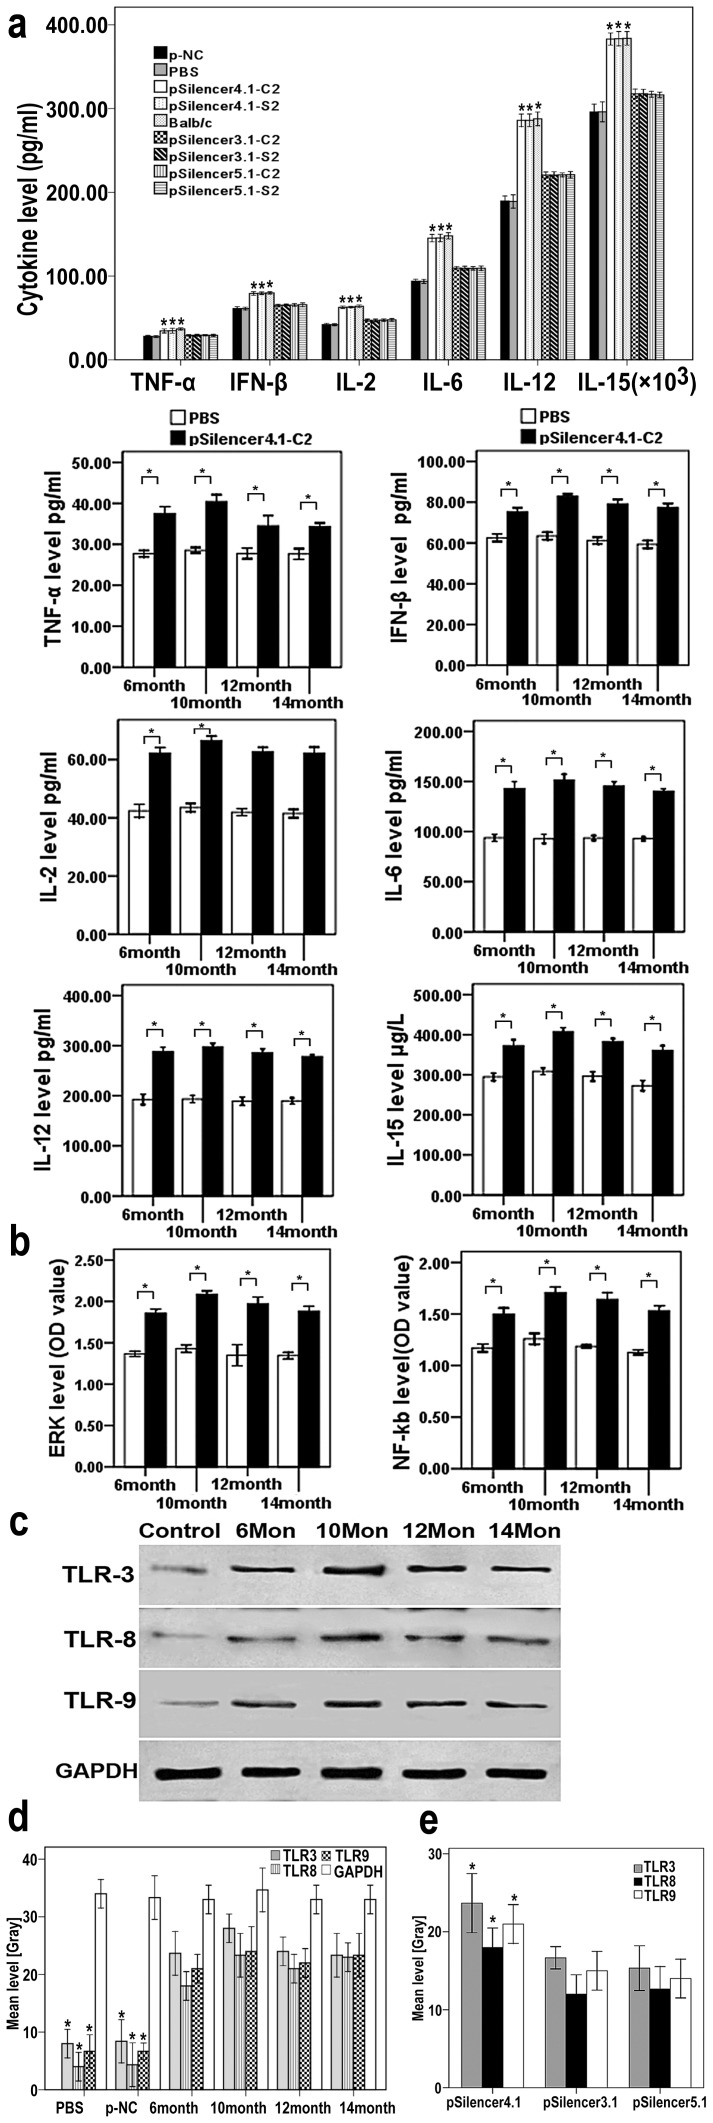
Effect of specific siRNAs on the innate immune system of HBV transgenic mice.The changes in cytokines and TLRs of HBV transgenic mice were measured by enzyme linked immunosorbent assay (ELISA) and western blot after 6, 10, 12, and 14 months treated with pSilencer4.1-C2 (p-4.1-C2) (a, b, c). The cytokines TNF-α, IFN-β, IL-2, IL-6, IL-12, and IL-15 were determined in the serum of transgenic mice by ELISA (a). And the transcription factors NF-κb and ERK were semi-quantitatively assessed in the serum of transgenic mice by ELISA (b). Western blots (c) showed the differences in TLR3, TLR8, and TLR9 between control and p-4.1-C2-treated groups. And the quantification of the results were displayed as well (d). The p-NC and PBS injected groups were set as controls. The expression of TLRs were higher in the p-4.1-C2 group to the other two groups at 12-month post-transfection (e). Error bars represent the standard error (SE) of septuple specimens. Results are representative of at least four separate experiments. n = 6–8 mice per group. p-NC, negative-control plasmid; PBS, phosphate-buffered saline; Mon, month. (*p<0.05).